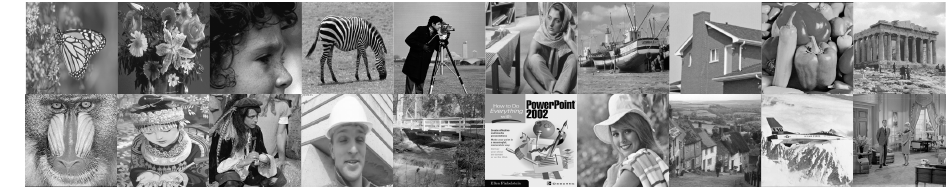
Figure 2. The 20 widely used test images.